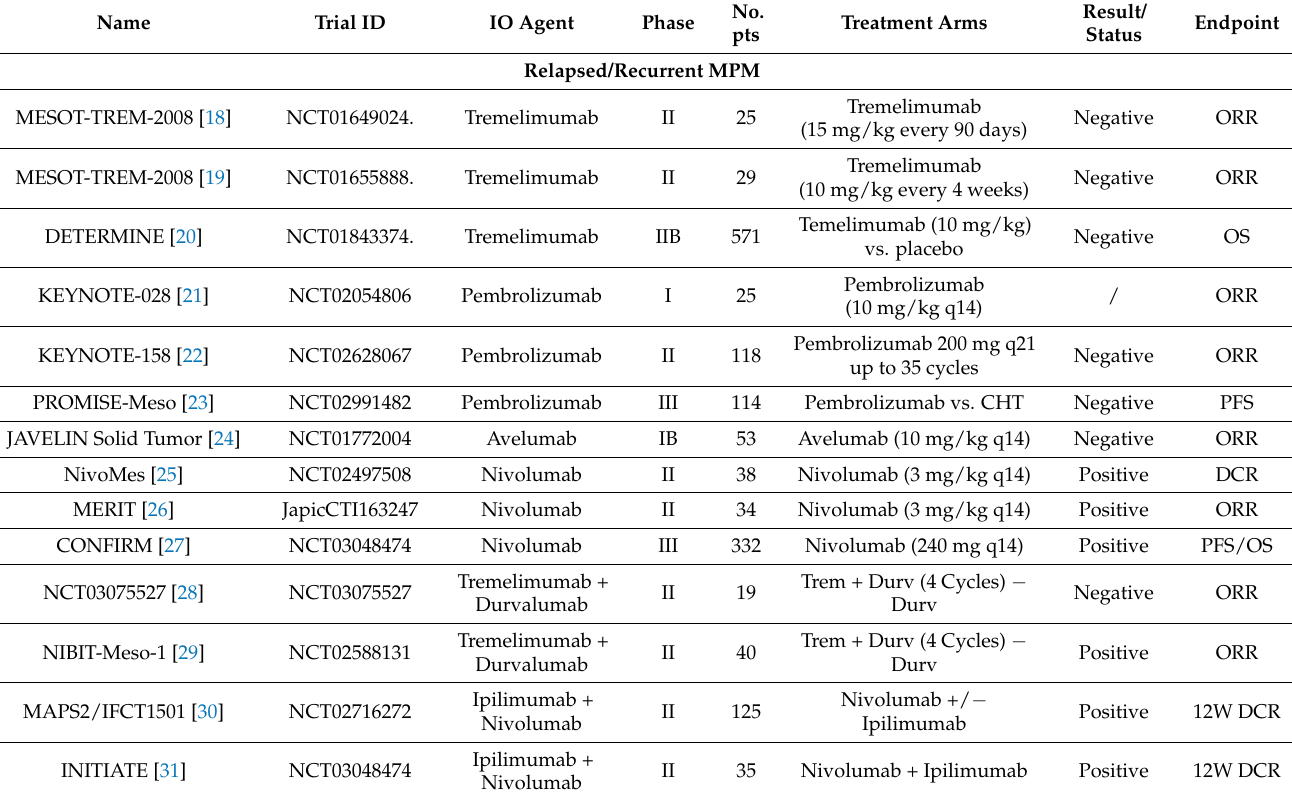
Table 1. Selected Clinical Trials investigating Immunotherapy in